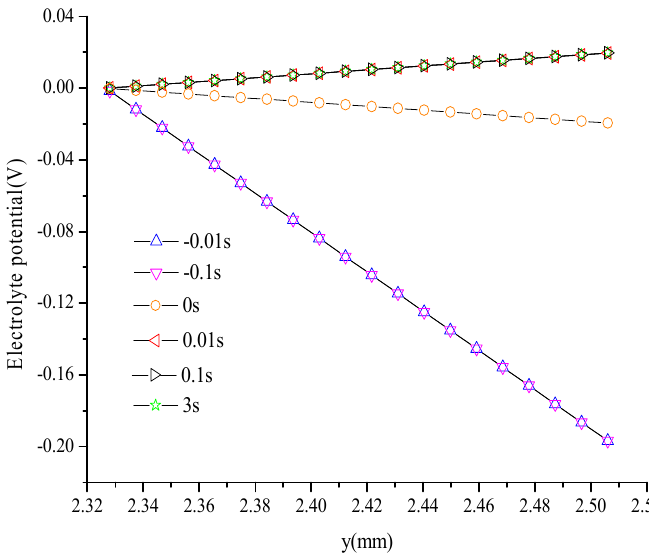
Figure 12. Evolution of electrolyte potential with time along line A–A in operation mode switching.